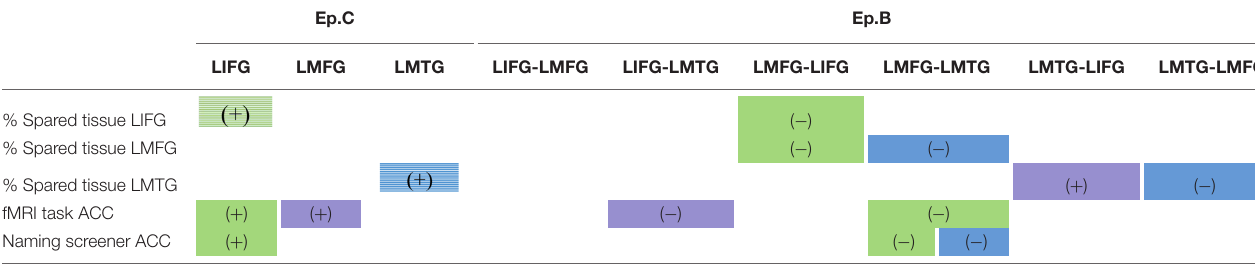
TABLE 5 | Summary of correlations between connectivity parameters and spared cortical tissue and behavior.